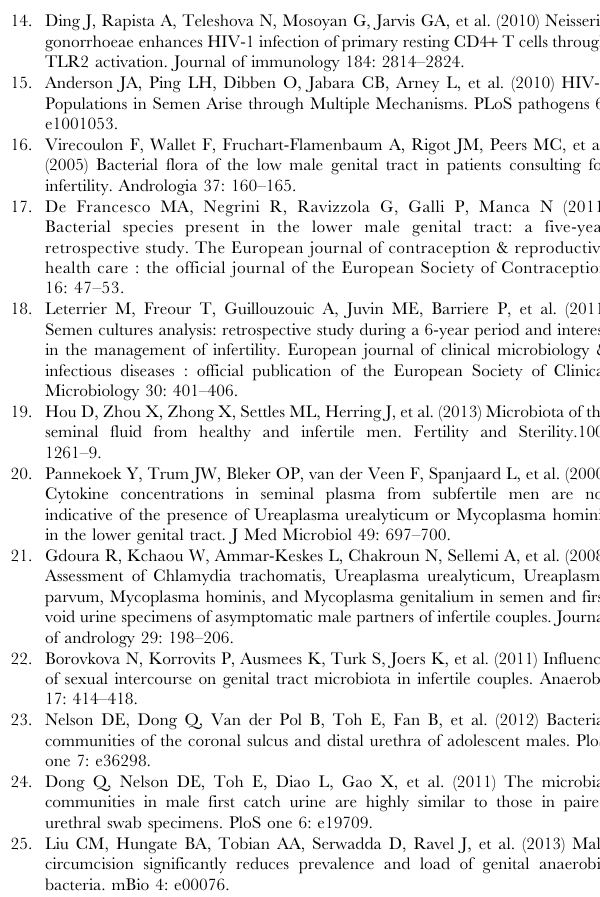
semen bacterial genus ( e.g. , Propionibacterium ) is shown and can be interpreted using the annotated color-coding key ( right , color bar), which denotes the color for its respective proportional abundance. The heatmap shows a wide range of semen bacteria, but few are more than 25% proportional abundant in a given sample. Figure S3 Semen microbiome composition and its correlation with semen bacterial load and CD4 + T-cell counts in HIV-uninfected (n= 22) and HIV-infected men (n =27). In this set of non-metric multidimensional scaling plots ( Panels A–B ), each data point represents the full semen microbiome of a single sample. Panels A and B have the same background nMDS plot, while in Panel A, the semen bacterial load (log10-transformed) from each group was fitted as vector and in Panel B, the CD4 + count was fitted. The corresponding R- square and p-value for each vector in each group is as shown. The semen microbiome in HIV-uninfected men was correlated with semen bacterial load, and this correlation was also seen in HIV- infected men prior to antiretroviral treatment ( Panel A ). However, after six months of treatment, CD4 + T-cell counts became significantly correlated with the semen microbiome ( Panel B ). There was no overall composition difference between the semen microbiome of HIV-uninfected men from men who are infected by HIV, as shown by the overlapping 95% confidence interval ellipses ( Panel A–B ).